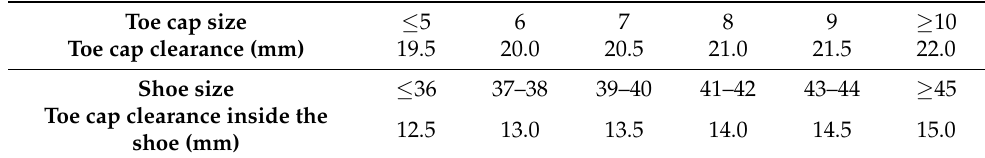
Figure 1. ( a ) 3D front and back view and ( b ) 2D cross-section and back view with general dimensions of the scanned left side size 10 toe cap; ( c ) cross-section view before deformation and at the maximum deformation. Table 2. Minimum clearance value after impact and compression as a function of the size of toe cap and inside the safety footwear